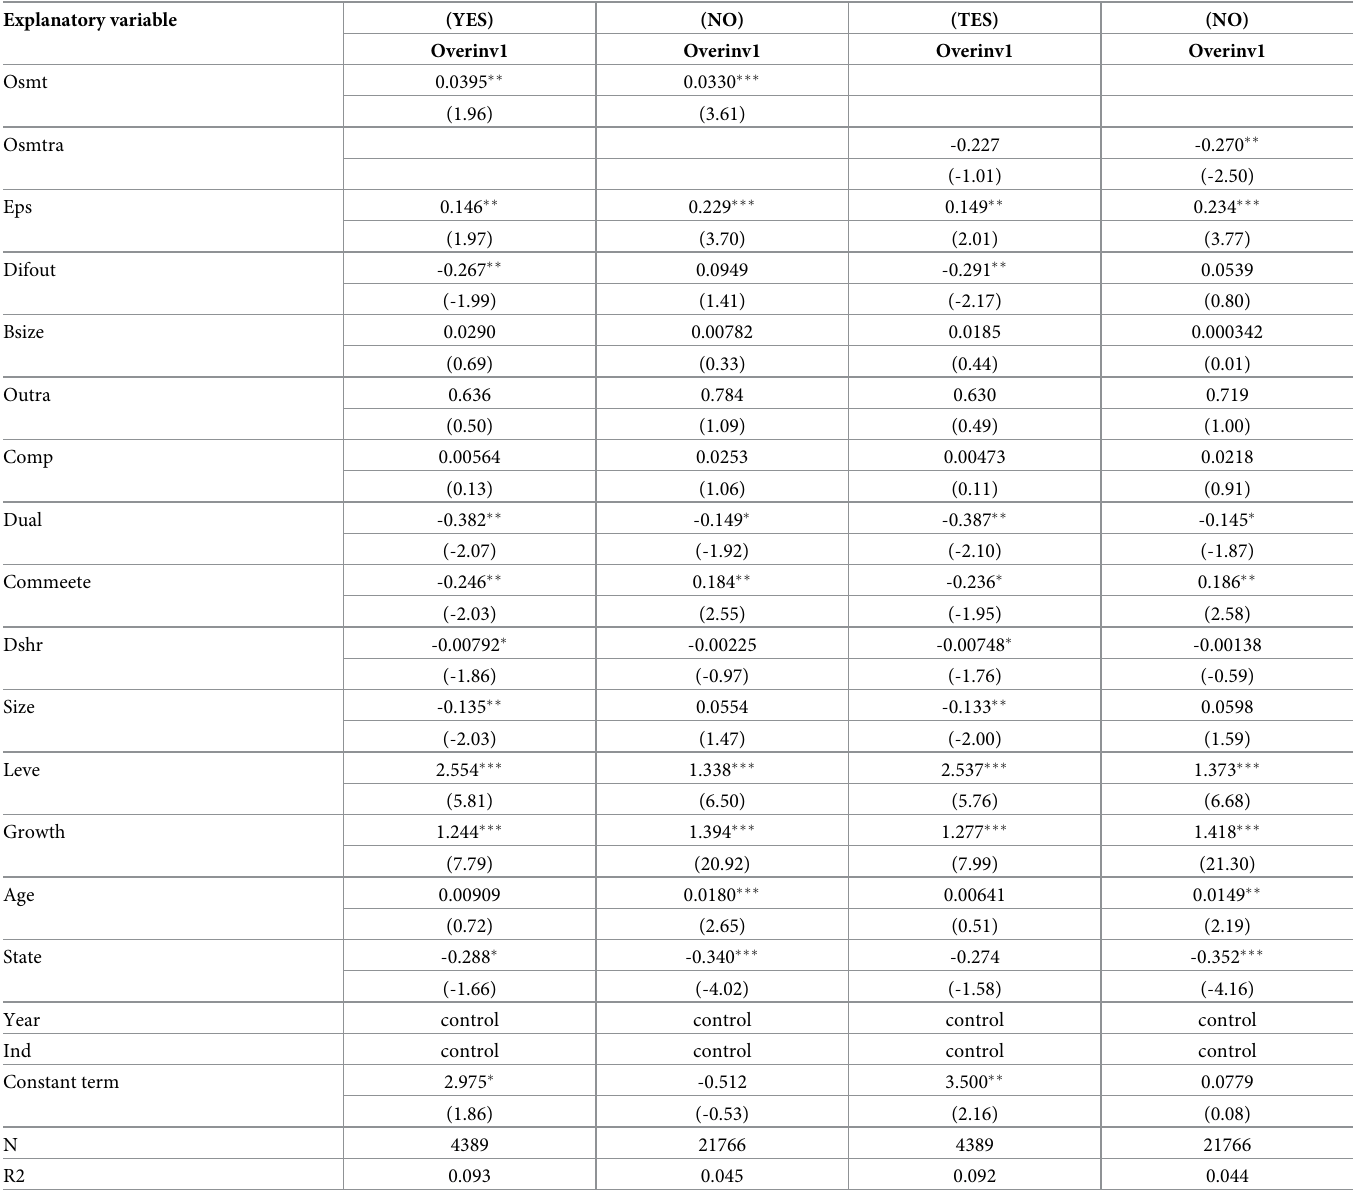
Table 4. Whether the company has a controlling